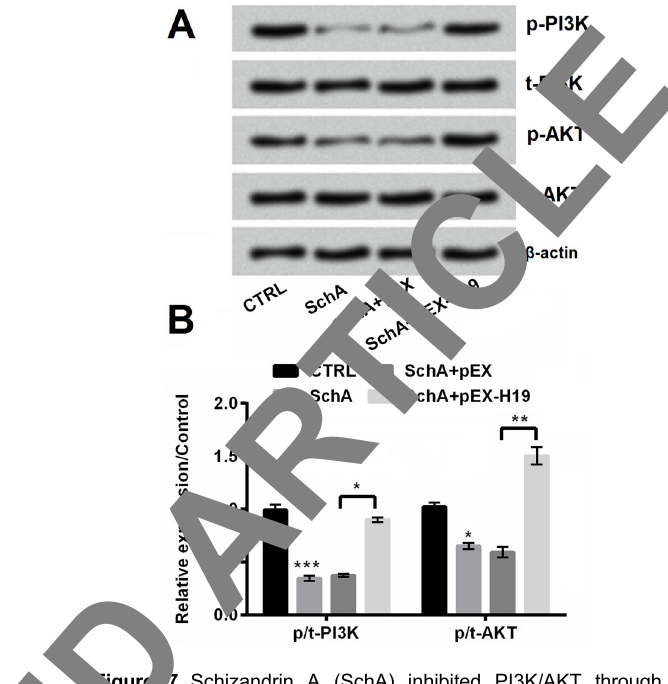
Figure 7. Schizandrin A (SchA) inhibited PI3K/AKT through down-regulation of H19. A , Phosphorylation of PI3K and AKT was detected by western blot. B , Levels of p/t-PI3K and p/t-AKT were analyzed quantitatively. b -actin was used as control. Data are reported as means ± SD (n=3). *P o 0.05, **P o 0.01, and ***P o 0.001 compared to control or as indicated